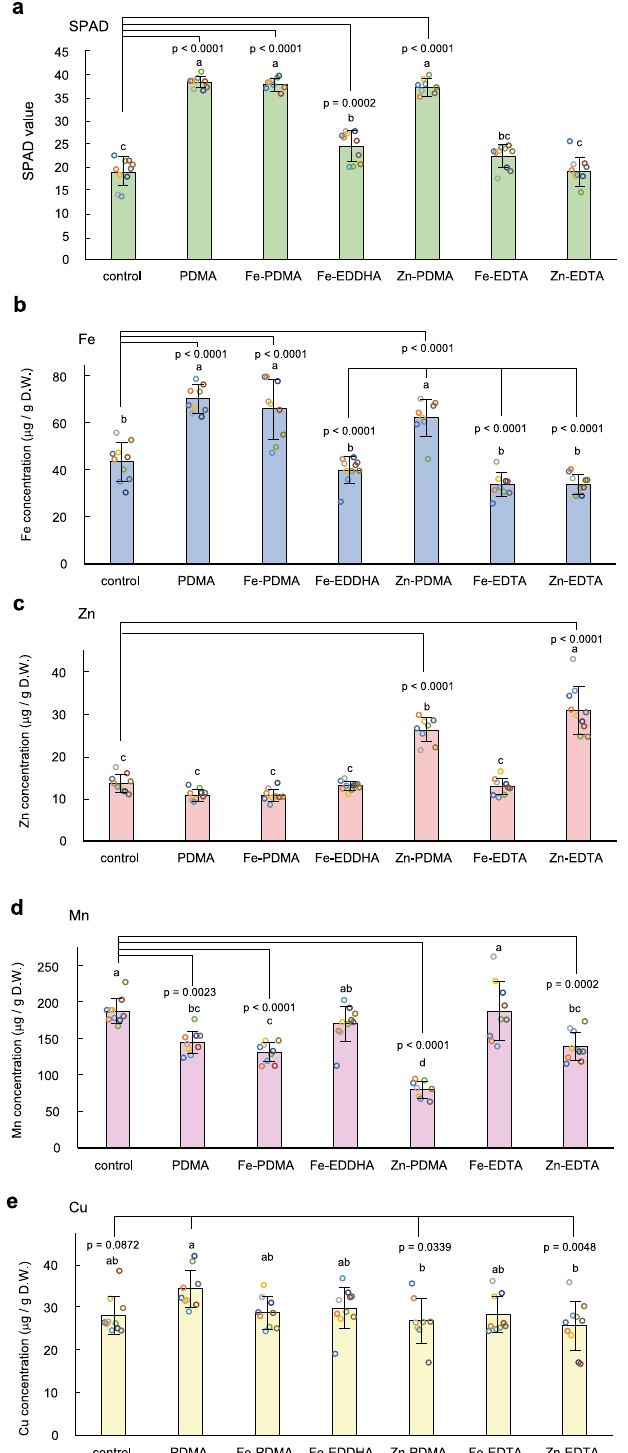
Fig. 6 SPAD values and metal concentrations in the newest leaves of rice plants supplied with chelating agents. a SPAD values were measured 7 days after a single application at 4 days after transplantation. b – e Metal concentrations in the newest leaves. Ten pots were used in each treatment, and three rice plants were grown in each pot. The three newest leaves in each pot were collected and used for measurement of SPAD values and metal concentrations by inductively coupled plasma optical emission spectrometry. The colors of the plots of each treatment through a – e indicate samples from the same pots. Values are means with standard deviations indicated by error bars ( n = 10 for control, Fe-EDDHA and Zn-EDTA, n = 9 for PDMA, Fe- PDMA, and Fe-EDTA, and n = 8 for Zn-PDMA, after excluding outliers of Fe concentration), in which each replicate is either average of three plants in each pot for a , or total metal concentration of the three plants in each pot for b – e . Different letters indicate signi fi cant differences at P < 0.05 by Tukey ’ s honestly signi fi cant difference test (two-sided). PDMA proline-2 ′ -deoxymugineic acid, EDDHA ethylenediamine- N , N ′ -bis(2-hydroxyphenylacetic acid), EDTA ethylenediaminetetraacetic acid, SPAD soil and plant analyzer development, D.W. dry weight. NATURE COMMUNICATIONS| (2021) 12:1558 |https://doi.org/10.1038/s41467-021-21837-6|www.nature.com/naturecommunications